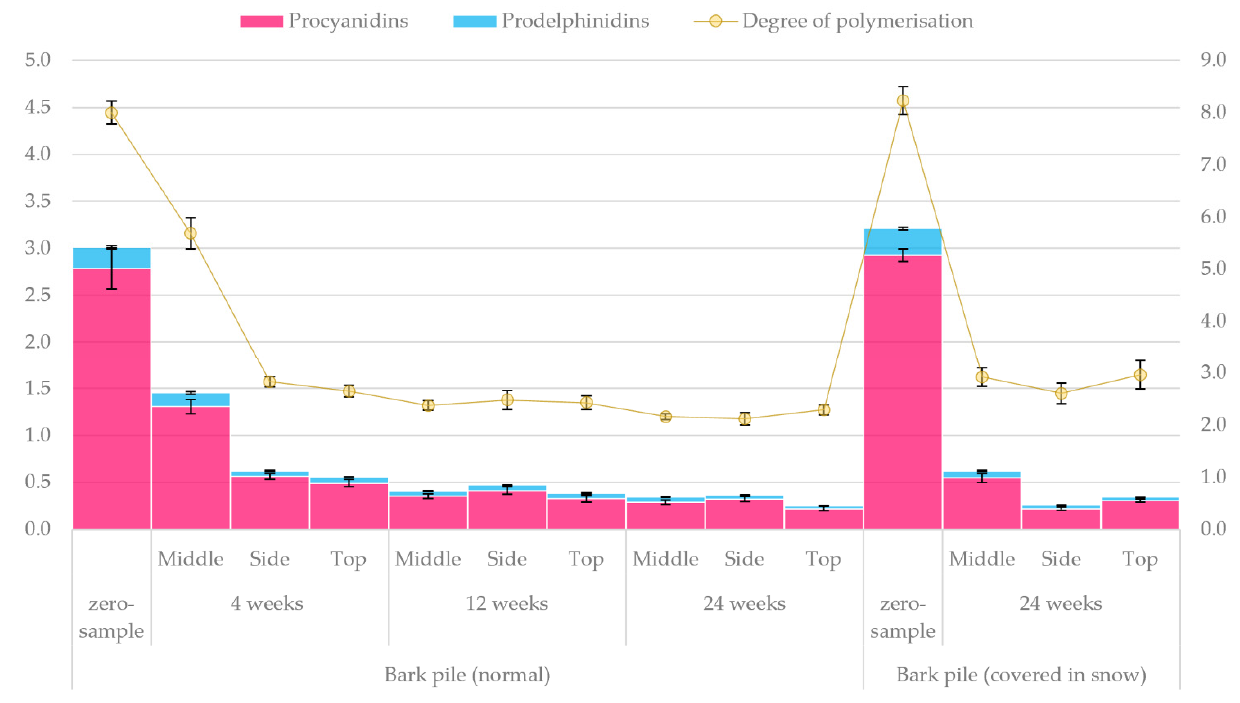
Figure 14. Quantified amounts of tannins (procyanidins, prodelphinidins) and the degree of polymerisation (DP) in freeze-dried bark samples under pile storage.